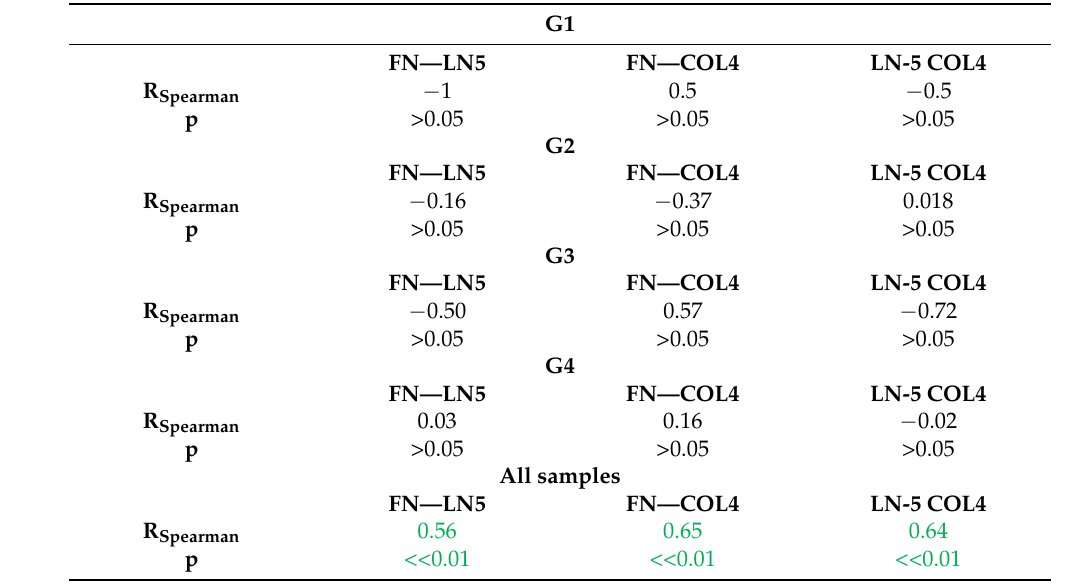
Table A3. Correlation analysis between